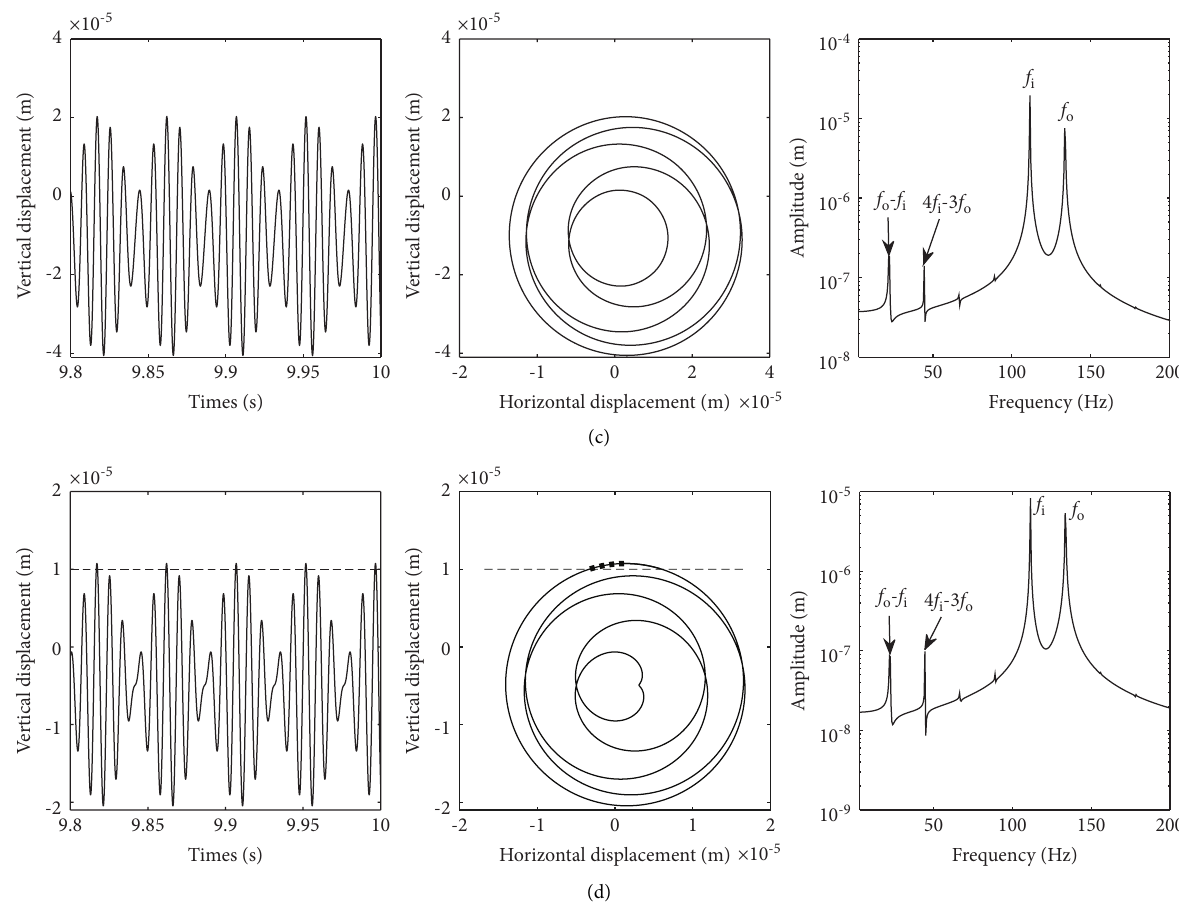
Figure 10: Dynamic responses of the MSDS with K response without rub-impact. (c) Inner rotor response with rub-impact. (d) Outer rotor response with